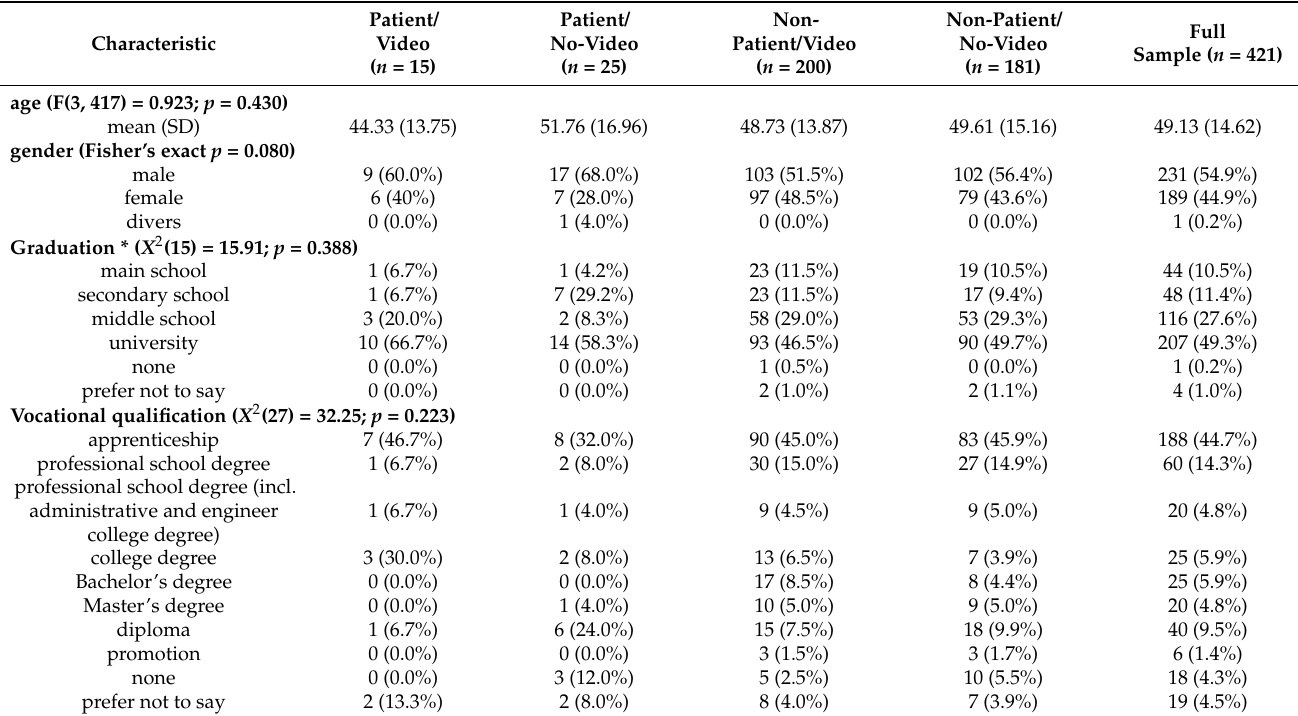
Table 1. Participants’ characteristics ( N =